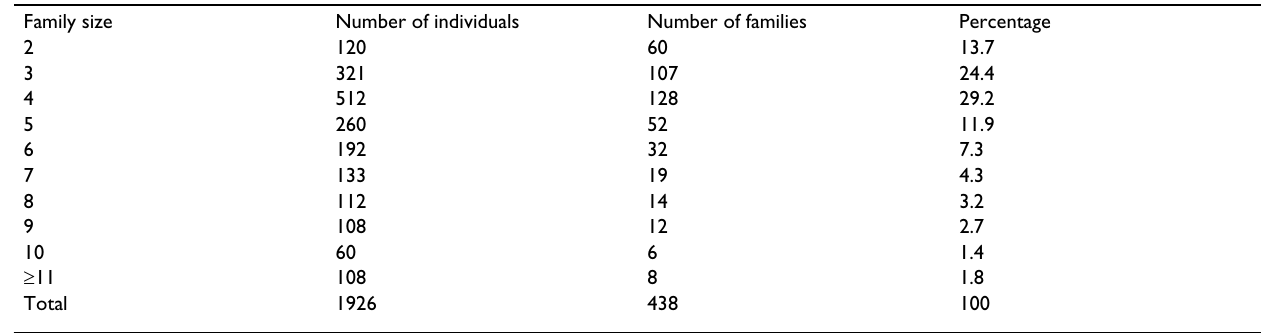
Table 2: Family size in the study sample Family size